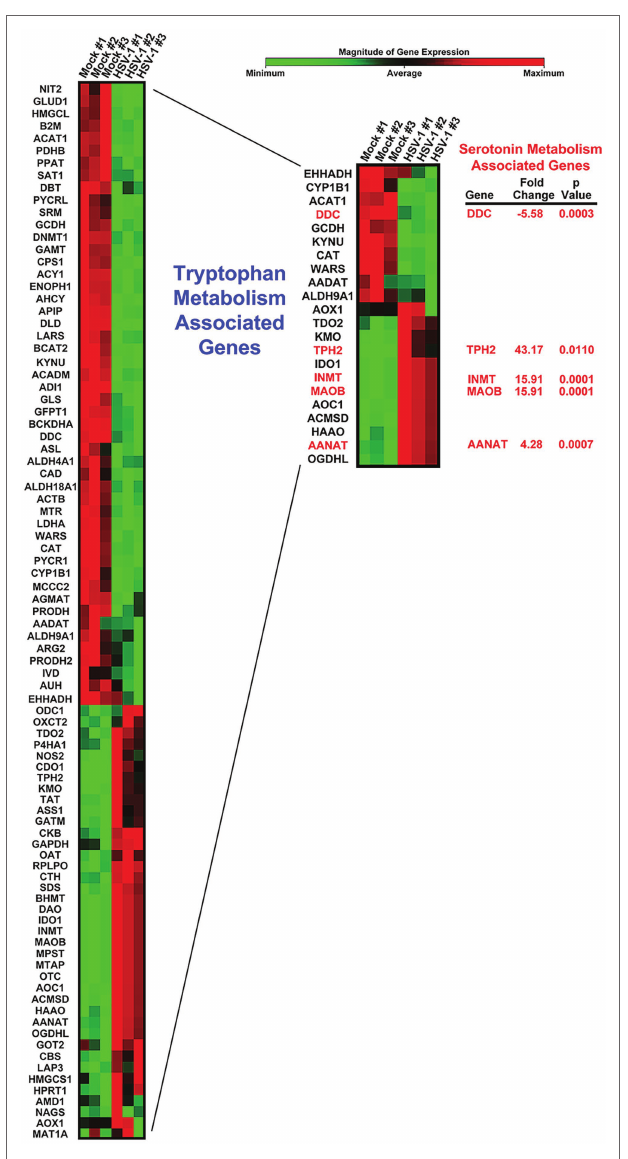
FIGURE 1 | Heat map comparison of host cell amino acid metabolism gene expression following Herpes simplex virus (HSV)-1 Infection. Cells were either mock- or HSV-1-infected (MOI 5) in triplicate. Differential expression of amino acid metabolism-associated genes was determined by Qiagen RT 2 -PCR Profiler Array analysis. The resulting heat map depicting each of the genes is shown color coded by the relative magnitude of normalized gene expression. A subset of genes involved in tryptophan metabolism is displayed within the inset heatmap. Genes encoding enzymes involved in serotonin-associated metabolism are highlighted with their respective fold change and p